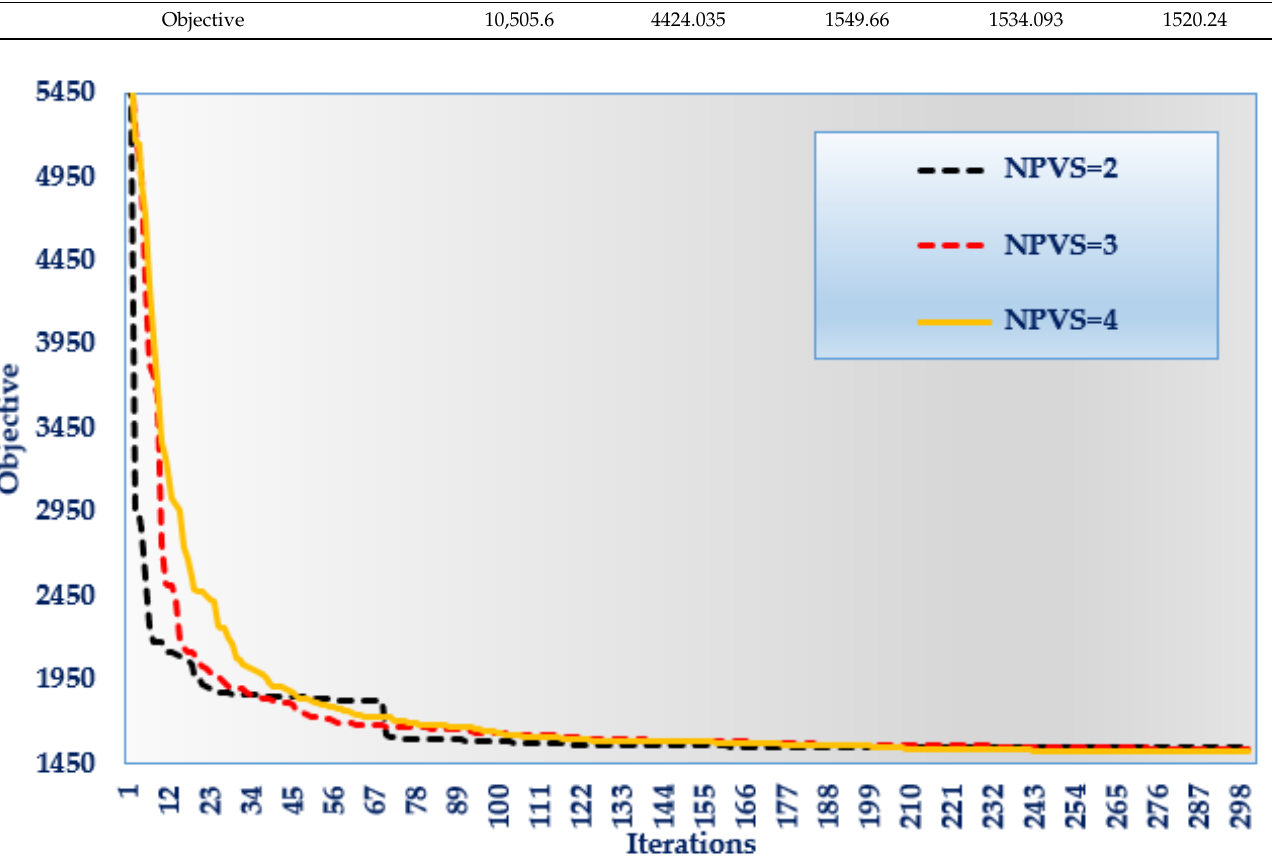
Figure 8. Convergence properties of HPO with varying the number of installed devices for IEEE 33-distribution feeder.